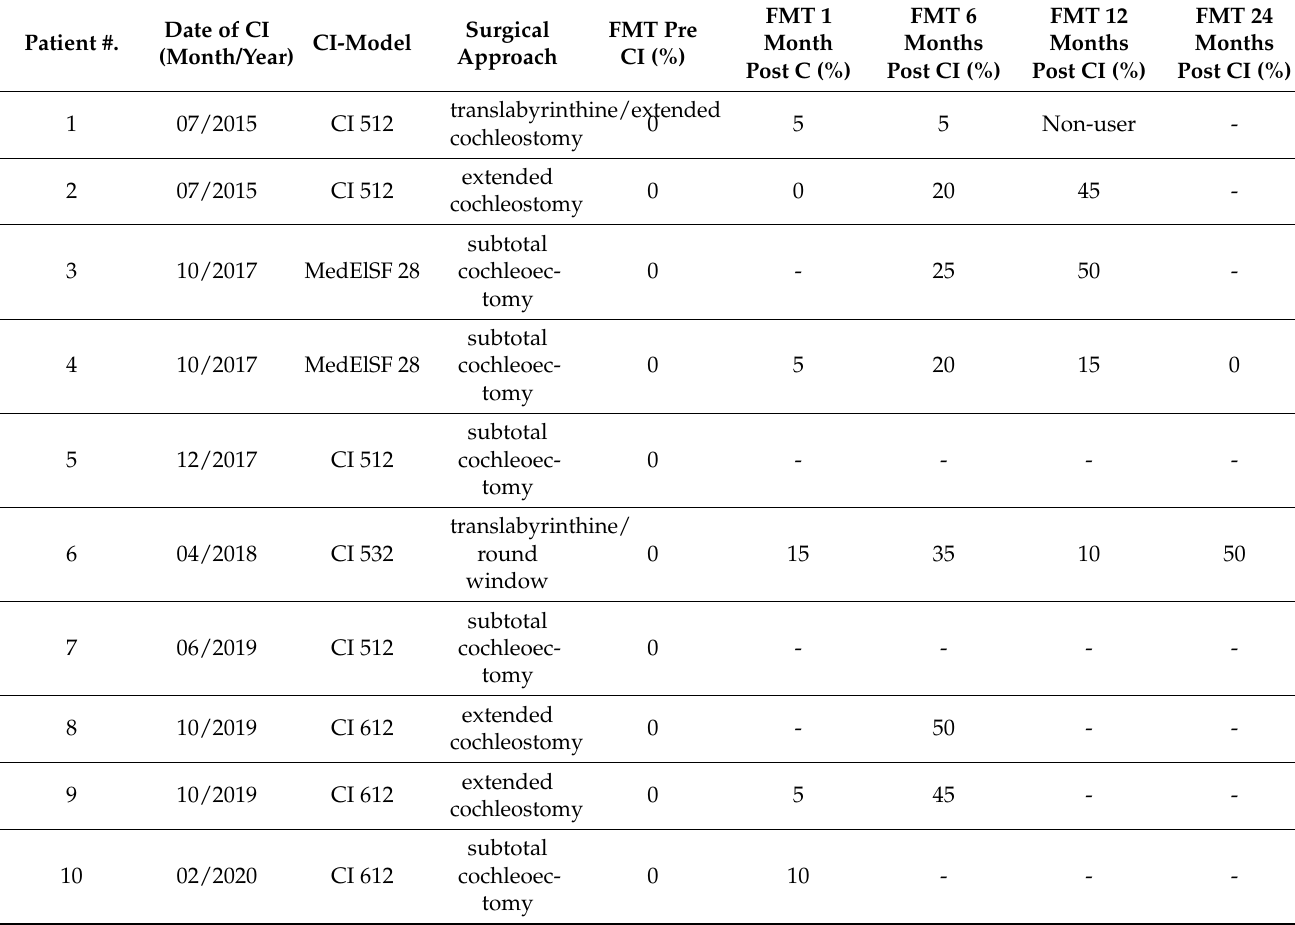
Table 2. Surgical approaches and speech perception in the operated ear following tumor resection and cochlear implantation. FMT = Freiburg Monosyllable Test.